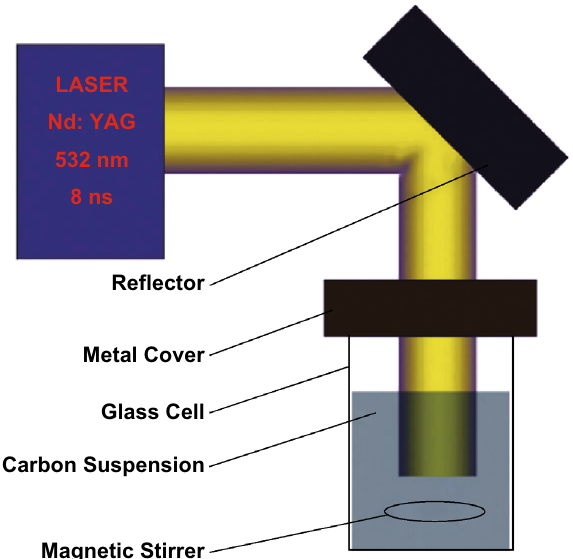
Fig. 2 Example of a laser ablation technique experimental setup [18]. Copyright (cid:2) 2011 The Royal Society of